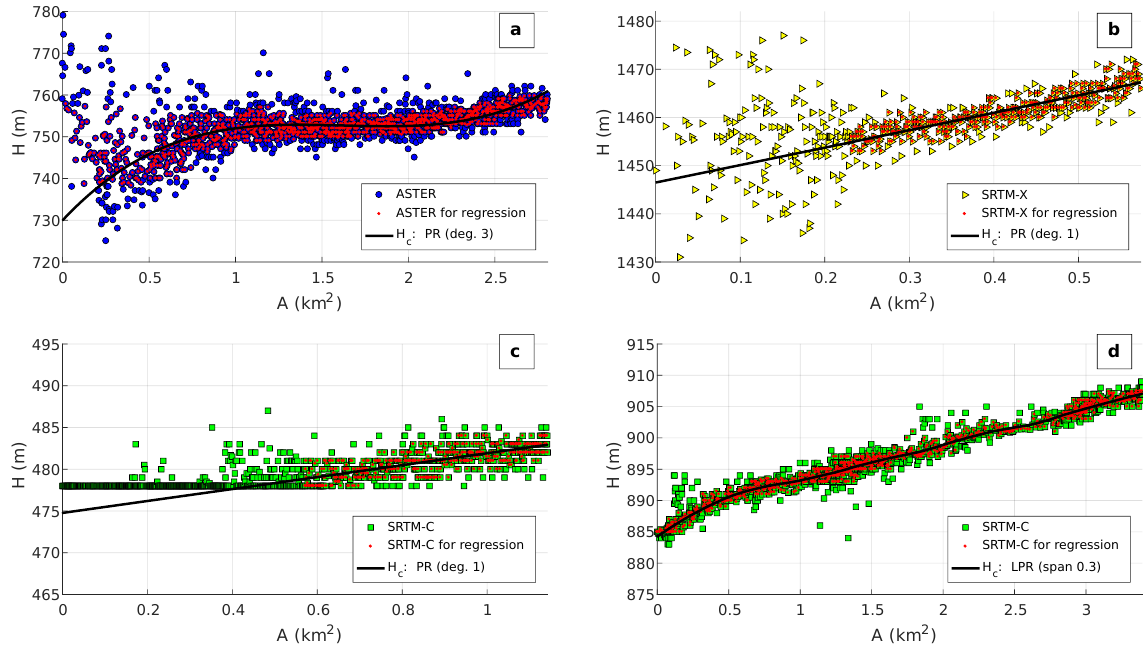
Figure 8. Elevation–area relationship and regression for a few reservoirs in the Yarmouk River basin: (a) Kudnah, (b) Roum, (c) Al Ghar, and (d) Qunaitera. Each symbol (circle, square, or triangle, depending on the DEM) represents the information associated with 1 pixel in a reservoir. PR and LPR stand for polynomial regression and local polynomial regression